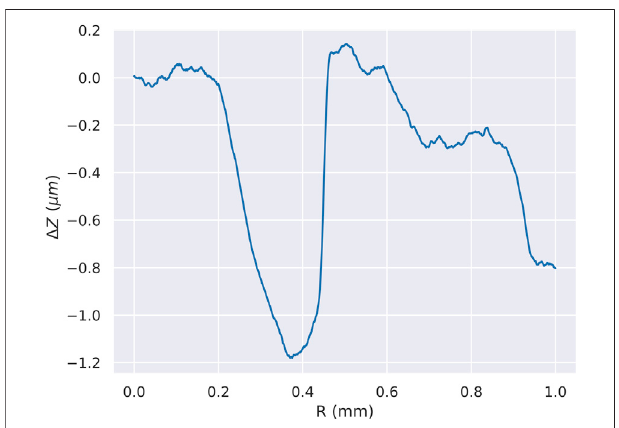
FIGURE 7 | The average of the difference pro fi les obtained by comparing each pair of X and Y pro fi les in the observation